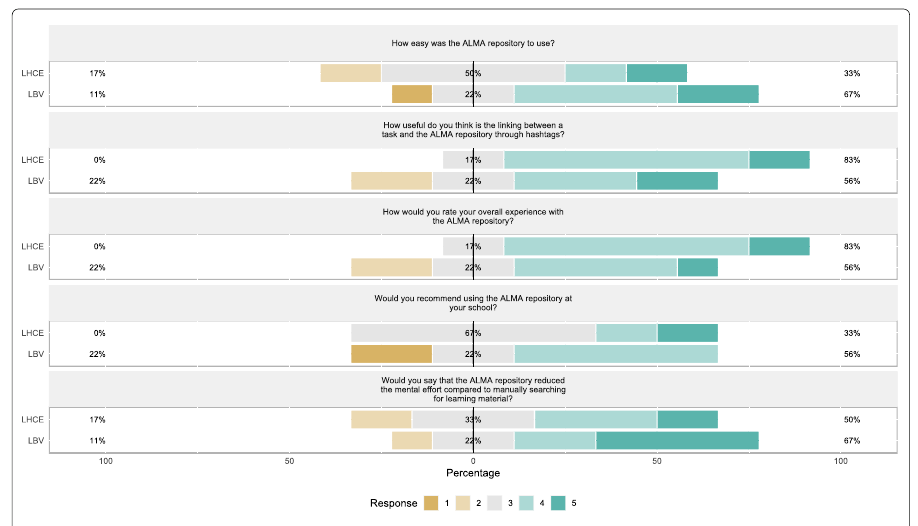
Fig. 15 Differences in the opinion about the ALMA approach between the two test groups